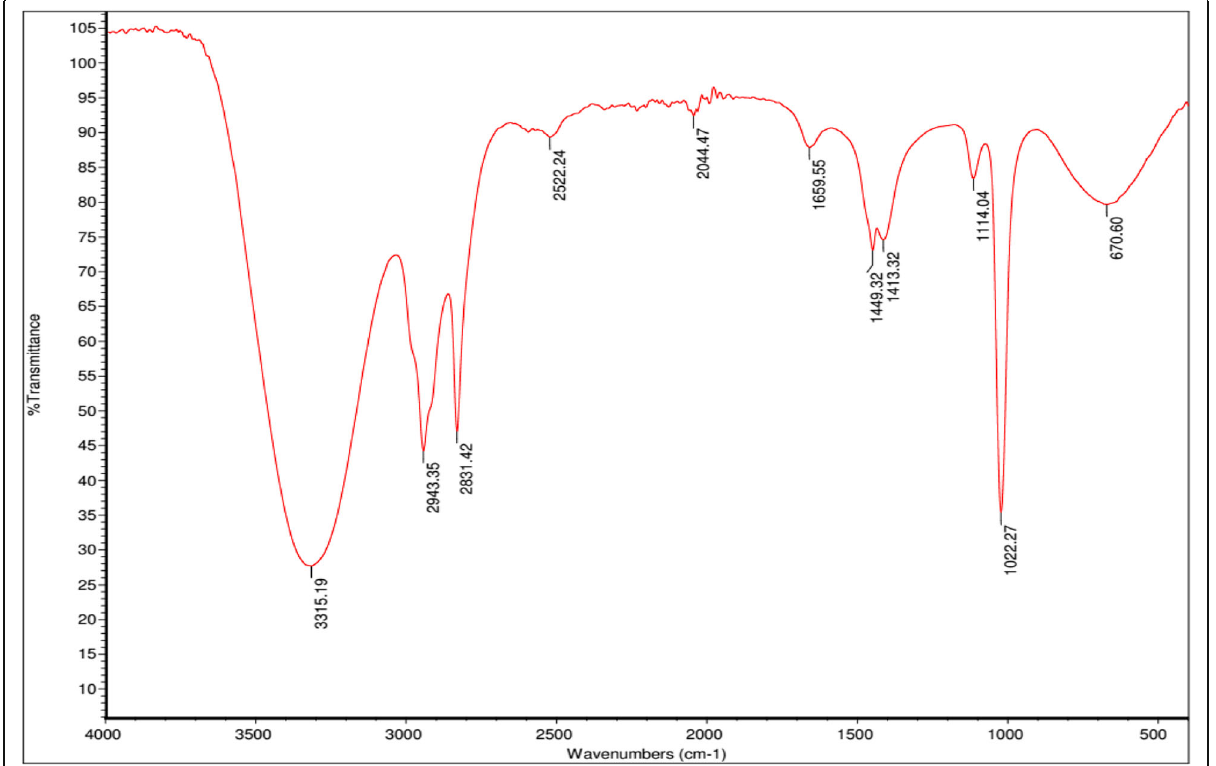
Fig. 4 IR fingerprint of the rich-phenolic extract isolated from ethyl acetate fraction of M. charantia fruit extract